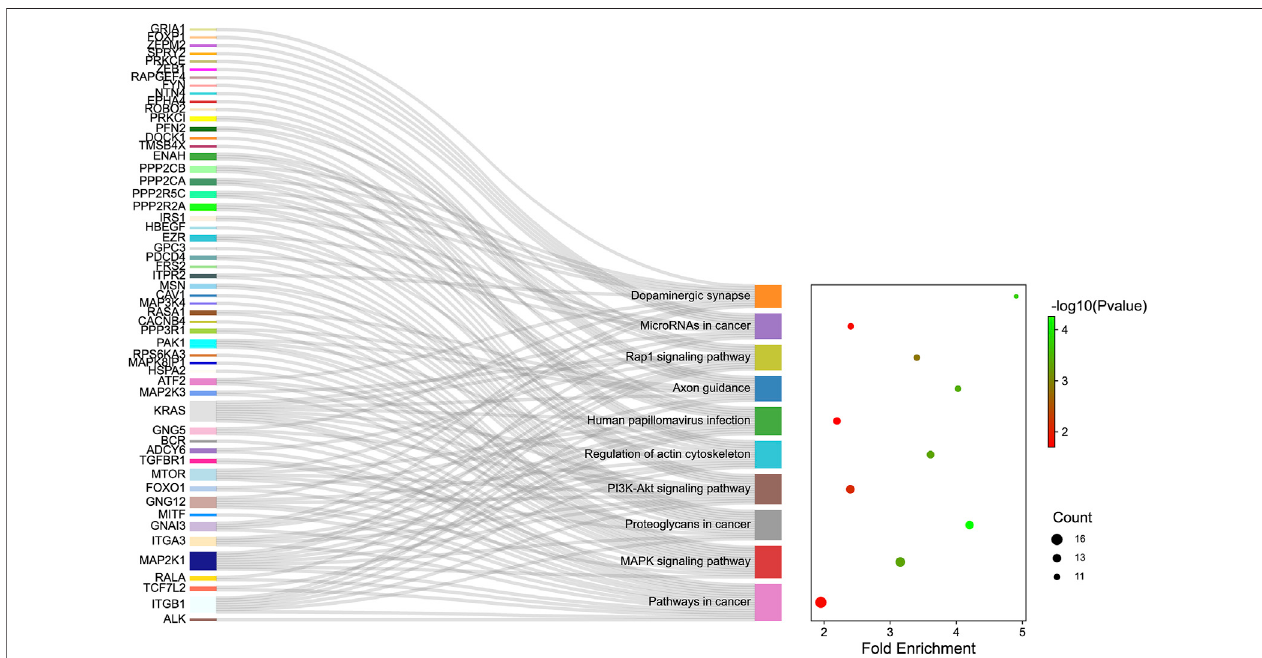
FIGURE7| TheKEGGenrichmentanalysisofup-regulatedgenes.The y -axisand x -axisdepictKEGG-enrichedtermsandtheGeneRatio,respectively.Thesizeof the dot means the number of genes and the color of the dots represents the p -value. The left cluster plot shows a chord dendrogram of clustering the expression spectrum of signi fi cantly DE genes. DE, differentially expressed; KEGG, Kyoto Encyclopedia of Genes and Genomes.